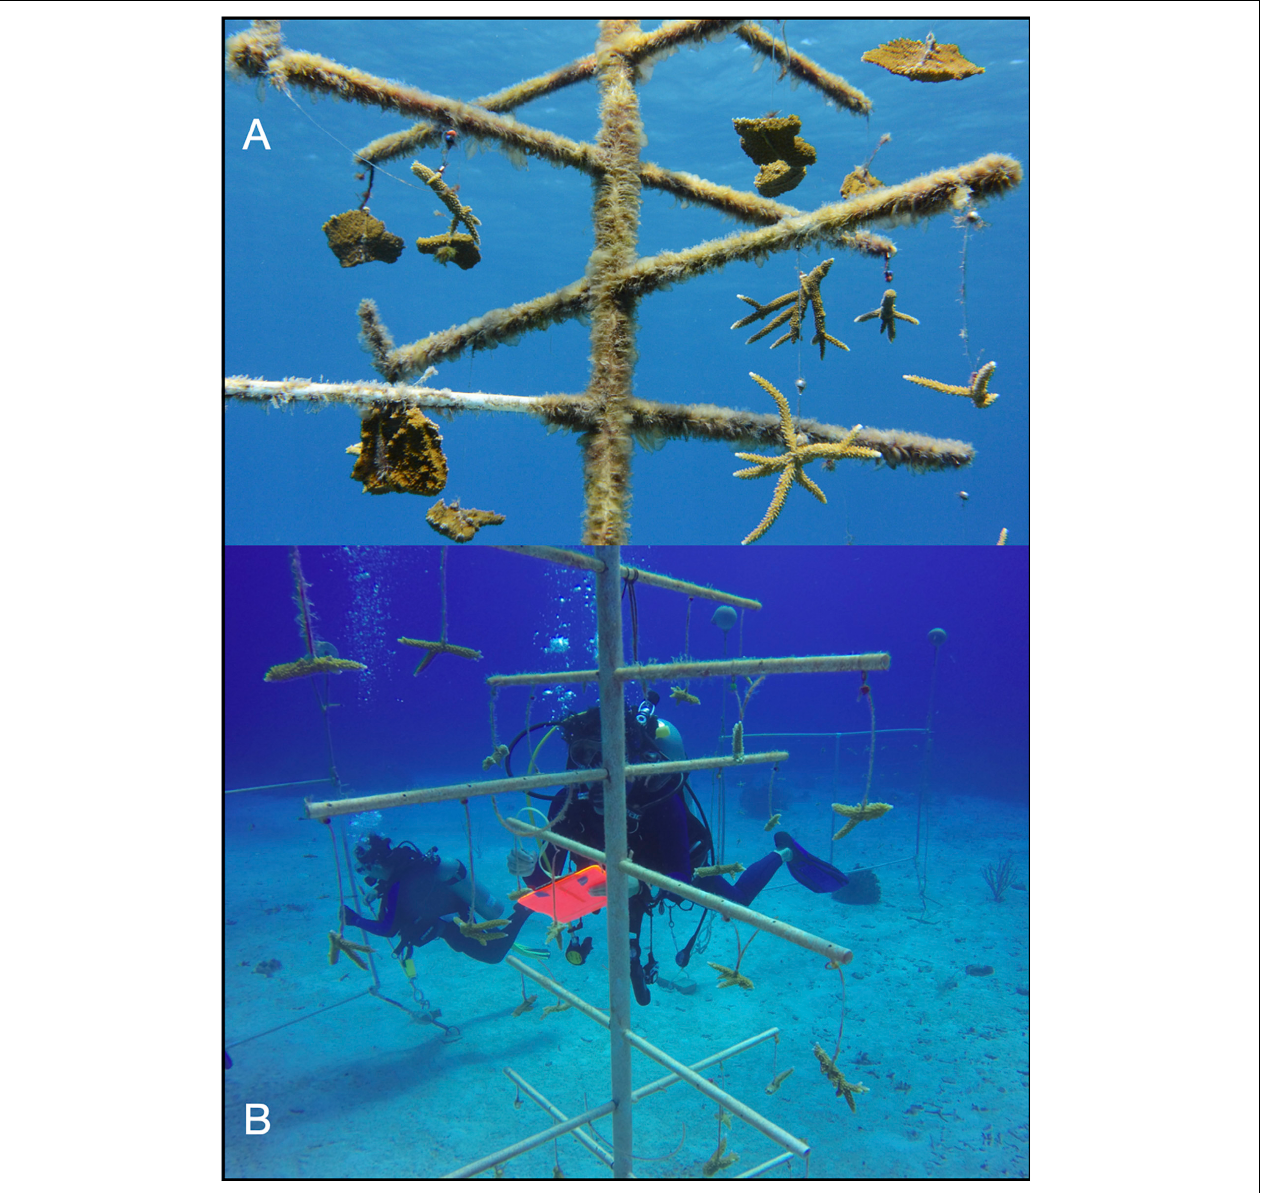
FIGURE 5 | Accumulation of biofouling on (A) a nursery at the shallow site and (B) a nursery at the deep site after approximately 1